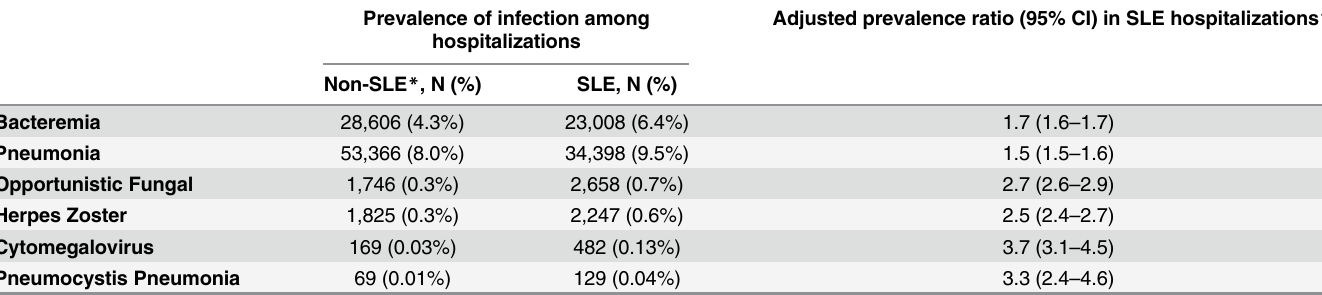
Table 2. Prevalence of specific infections in SLE hospitalizations compared with non-SLE hospitalizations in the National Inpatient Sample, between years 2000 and